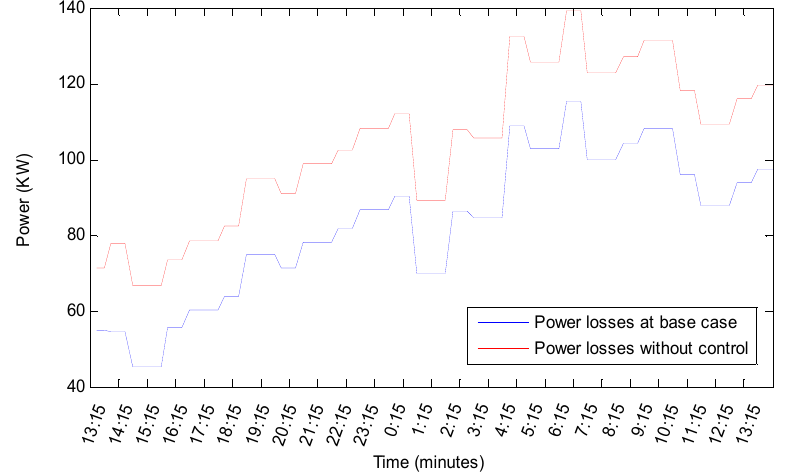
Figure 15. Power losses at base case and without charging control (dumb charging).